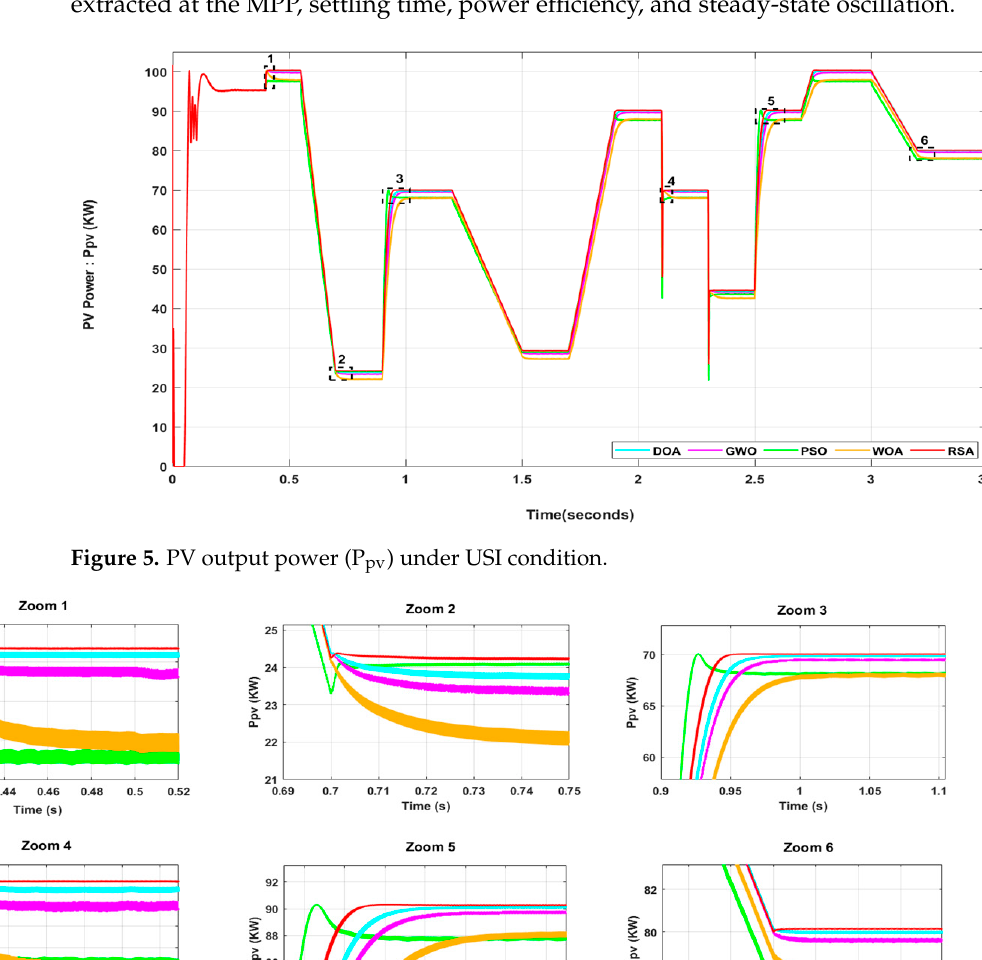
Figure 4. Illumination pro fi le of the uniform solar irradiance condition (USI).